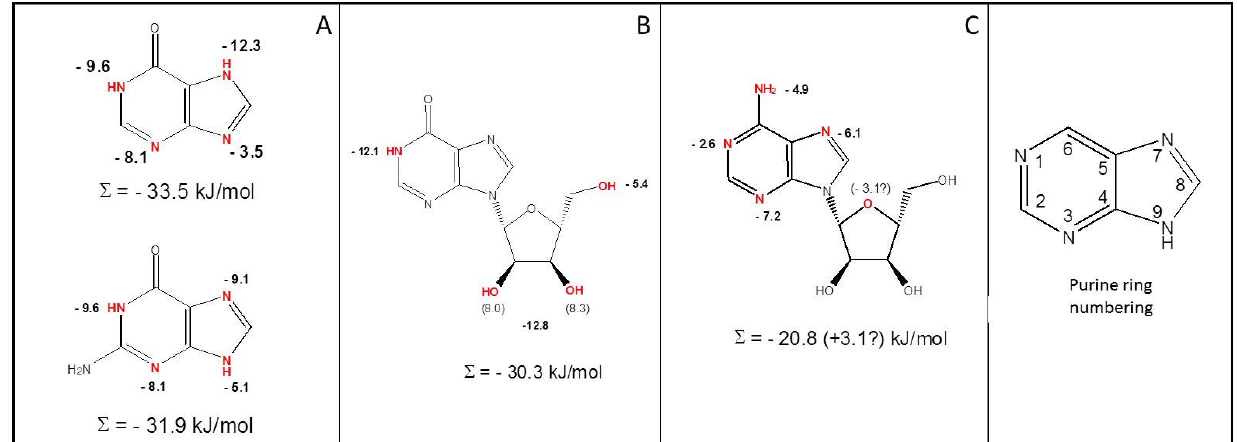
Figure 5. Substrate binding models for Tg244440. ( A ) Hypoxanthine (top) and guanine (bottom). ( B ) Inosine. ( C ) Adenosine. Inset: numbering of purine ring positions. Oval dashed lines represent proposed bonds, presumed to be hydrogen bonds; the numbers given with them are the estimated Gibbs free energy of interaction, in kJ/mol.